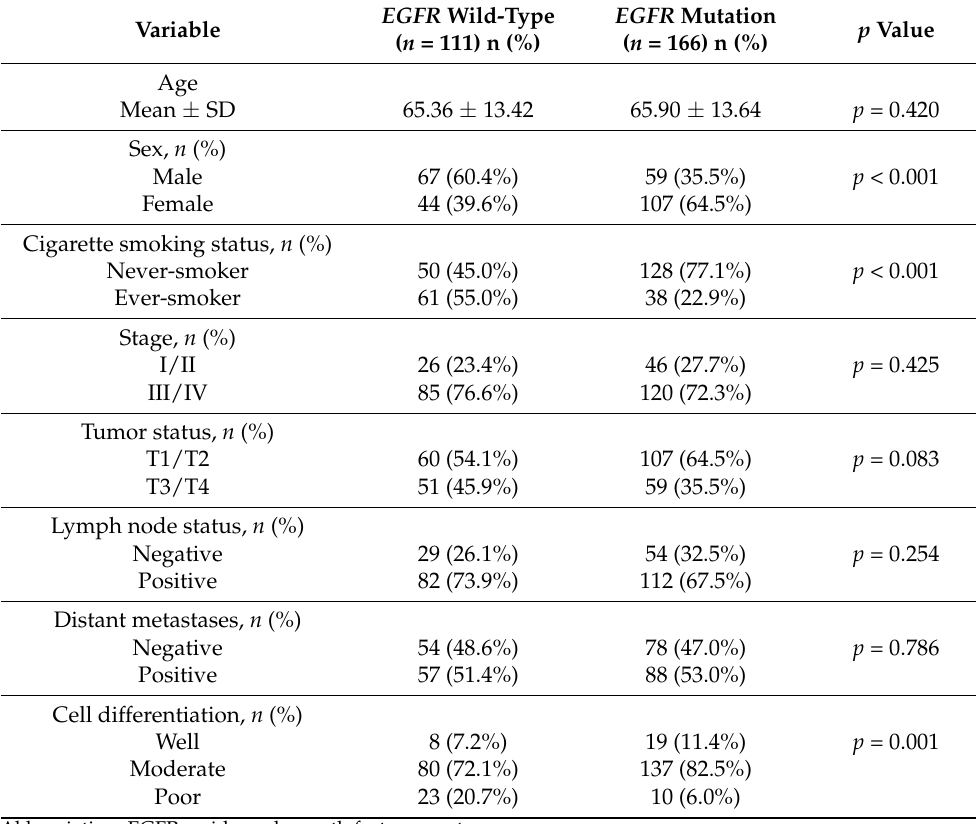
Table 1. Demographics, clinical characteristics and EGFR status of 277 lung adenocarcinoma patients.